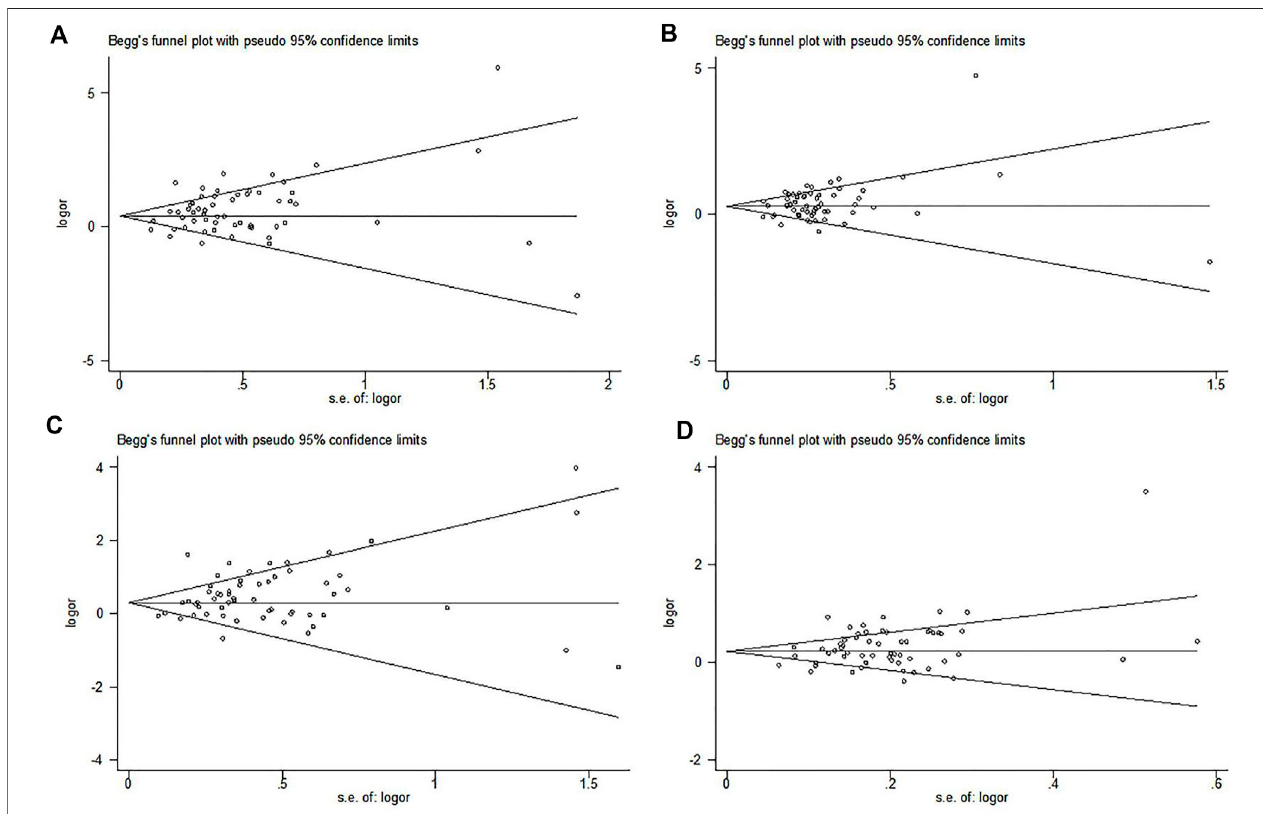
FIGURE 2 | Begg ’ s funnel plot to assess the publication bias of MTHFR C677T polymorphism in the overall population. (A) Allelic model, T vs. C; (B) dominant model, TT + TC vs. CC; (C) recessive model, TT vs. CC + TC; (D) homozygote genetic model, TT vs. CC.